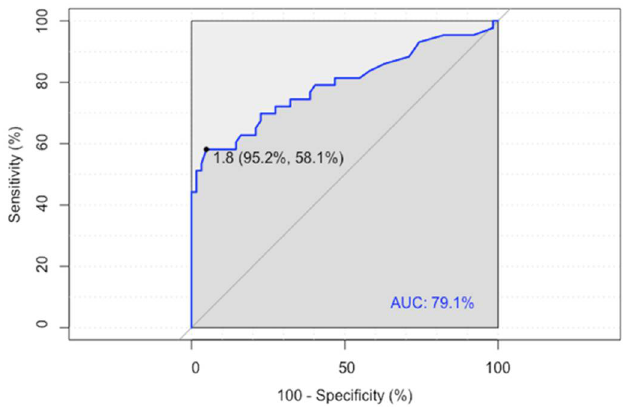
Figure 1. ROC analysis of the Lesion-to-Liver SUVmax ratio (LLR).